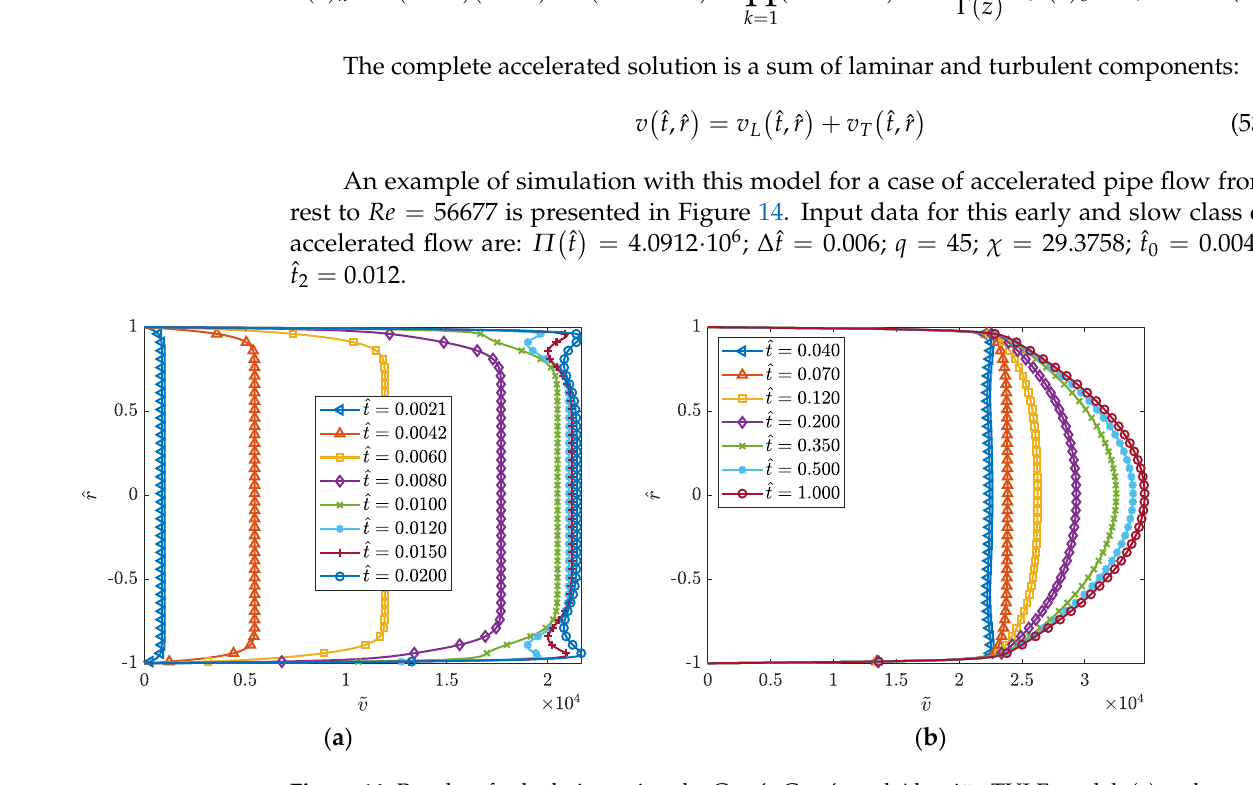
Figure 14. Results of calculation using the García García and Alvariño TULF model: ( a ) early stage; ( b ) late stage.